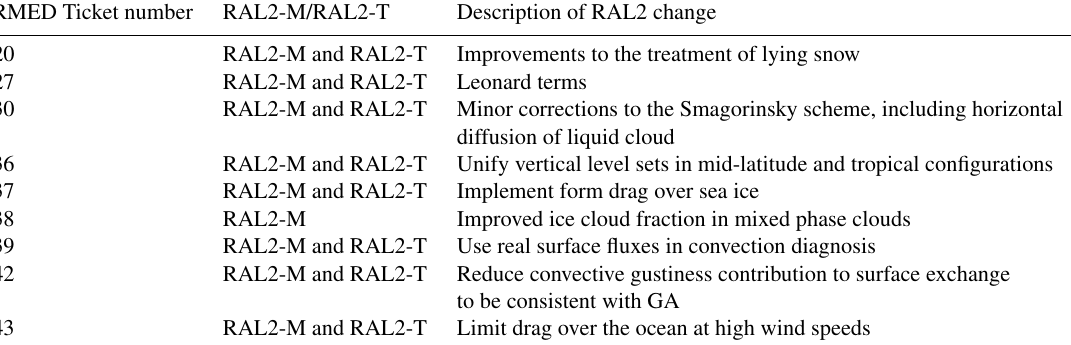
Table A3. RMED tickets included in